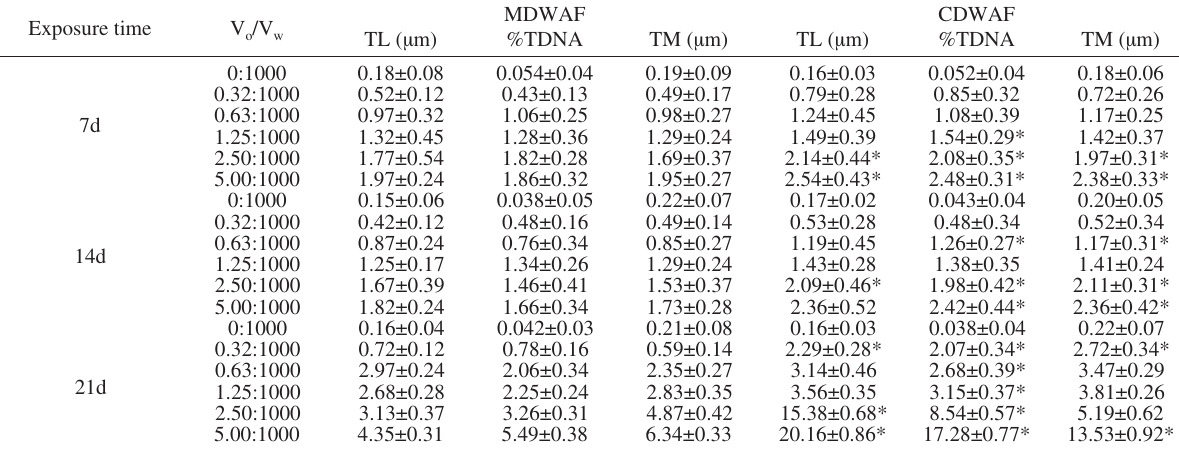
Table 5. – DNA damages (TL, tail length; %TDNA, tail DNA%; TM, tail moment) of sea urchin intestinal cells within 7.14 and 21 d; * indicates statistically significant differences (p<0.05) with respect to the corresponding MDWAF treatment. MDWAF Exposure time V /V o w